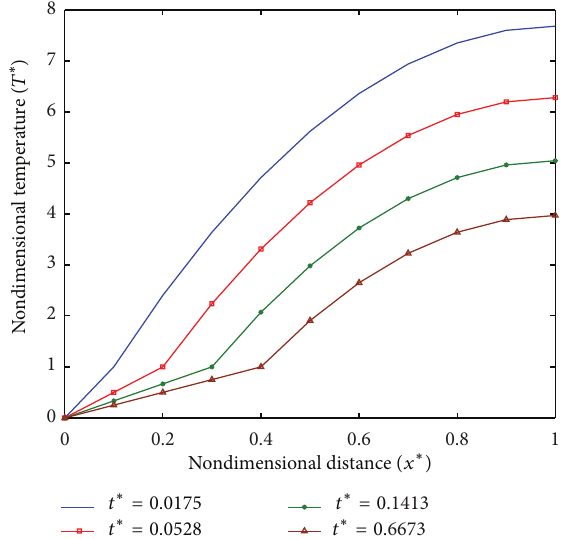
Figure 3: Temperature distribution at 𝑞 ∗ 𝑚 = 15.5 .